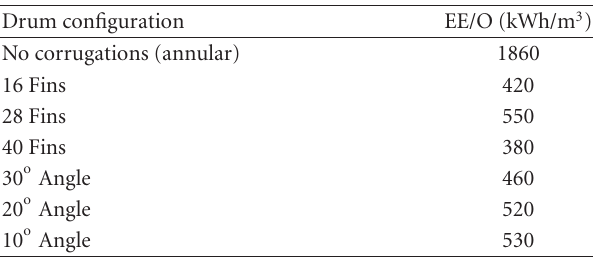
Table 3: EE/O for seven drum configurations. Drum